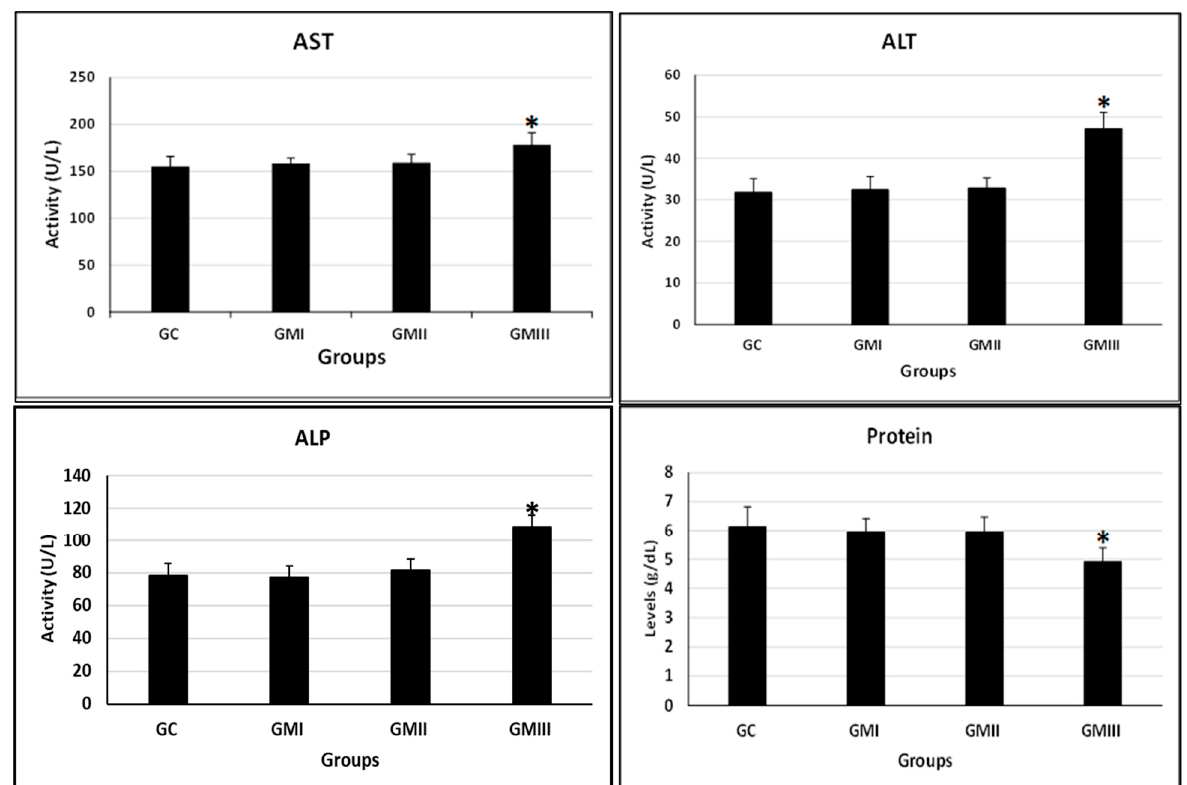
Figure 7. E ff ect of metronidazole on the serum liver function index of pregnant albino rats. Values are expressed as mean ± standard deviation (mean ± SD) n = 10/group. * The values are signi fi cantly di ff erent at p ≤ 0.05 (ANOVA) with Duncan’s multiple range test. Table 2. E ff ect of metronidazole on lipid pro fi le in pregnant albino rats.